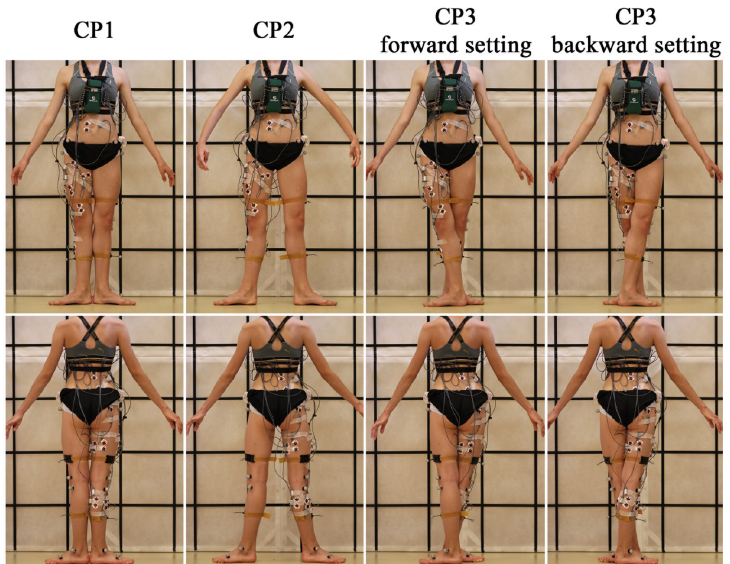
Fig 2. Presentation of classical ballet positions and electrode placement. First classical ballet position (CP1): both feet are turned in opposite directions, heels touch, the longitudinal axes of the feet form a single straight line. Second classical ballet position (CP2): position of the feet is the same as in CP1 but there is a distance of one foot between the heels. Third classical ballet position (CP3) with forward setting: both feet are turned in opposite directions, right foot is in front with heel touching the middle of the left foot. Third classical ballet position (CP3) with backward setting: position is the same as previous but the left foot is in front.